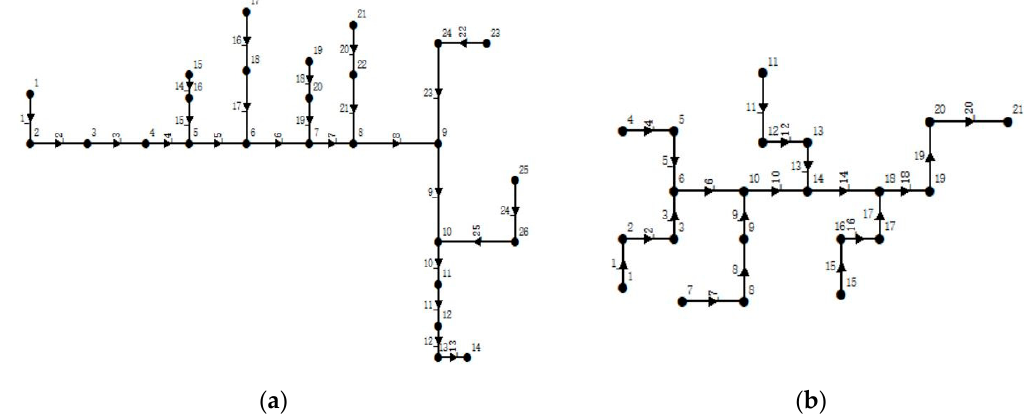
Figure 5. Layouts of the two sewer networks: ( a ) layout for case 1; ( b ) layout for case 2. Tables 1 and 2 summarize the basic storm sewer pipe data in cases 1 and 2, respectively. Table 1. Summary of basic storm sewer information in case 1.